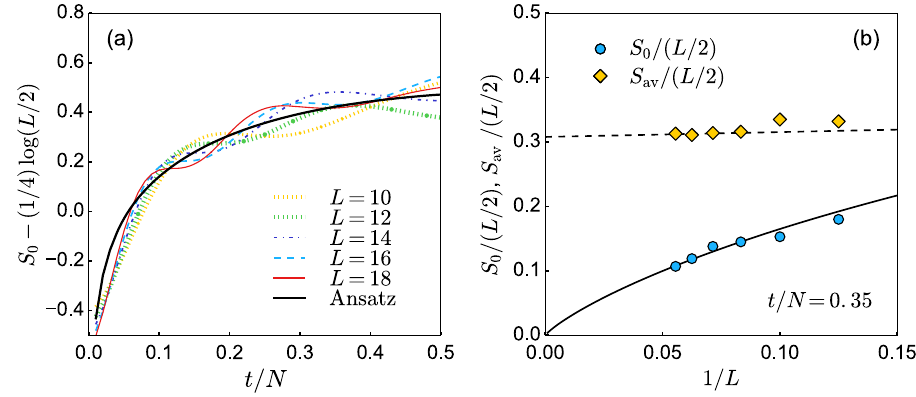
ˆ H t Þ [Eq. (35)] for V ¼ 1 . 2 . (a) Entanglement FIG. 6. Entanglement entropy of eigenstates of the emergent local Hamiltonian V ð entropy S 0 of the eigenstate j Ψ t i that describes the domain-wall melting, after subtracting ð 1 = 4 Þ log ð L= 2 Þ , for different system sizes L and N ¼ L= 2 . The thick solid line displays the ansatz in Eq. (41) with k 0 ¼ 0 . 529 as an average of k 0 ð L Þ for L ¼ 14 , 16, 18. [For a given L , we obtain k 0 ð L Þ by fitting the numerical result to Eq. (41).] (b) Entanglement entropy per site at time t=N ¼ 0 . 35 as a function of the inverse system size. Diamonds depict the average entanglement entropy S per site of D = 5 eigenstates of the many-body spectrum (see av text for details) (for L ¼ 18 , we average over 10 3 eigenstates). The solid line is obtained from Eq. (41) for the same value of k 0 as in (a). = ð L= 2 Þ ¼ a =L þ a L ≥ 14 , with a 0 . 076 and a 0 . 308 The dashed line is a linear fit to S 1 2 for 1 ¼ 2 ¼ av